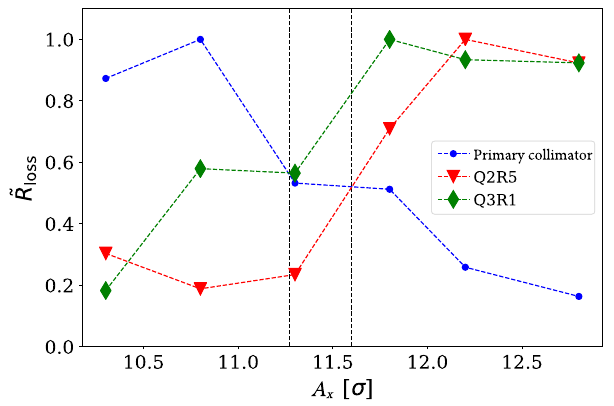
FIG. 12. Beam 2 horizontal aperture measurements for the 2017 top energy optics with β (cid:2) ¼ 30 cm. The normalized BLM signals at the primary collimator (blue) and at the bottleneck in IR5 (red) and IR1 (green) are shown as a function of the primary collimator half-gap. The corresponding half-gap at which the collimator and the bottleneck curves cross is indicated with dash black lines.